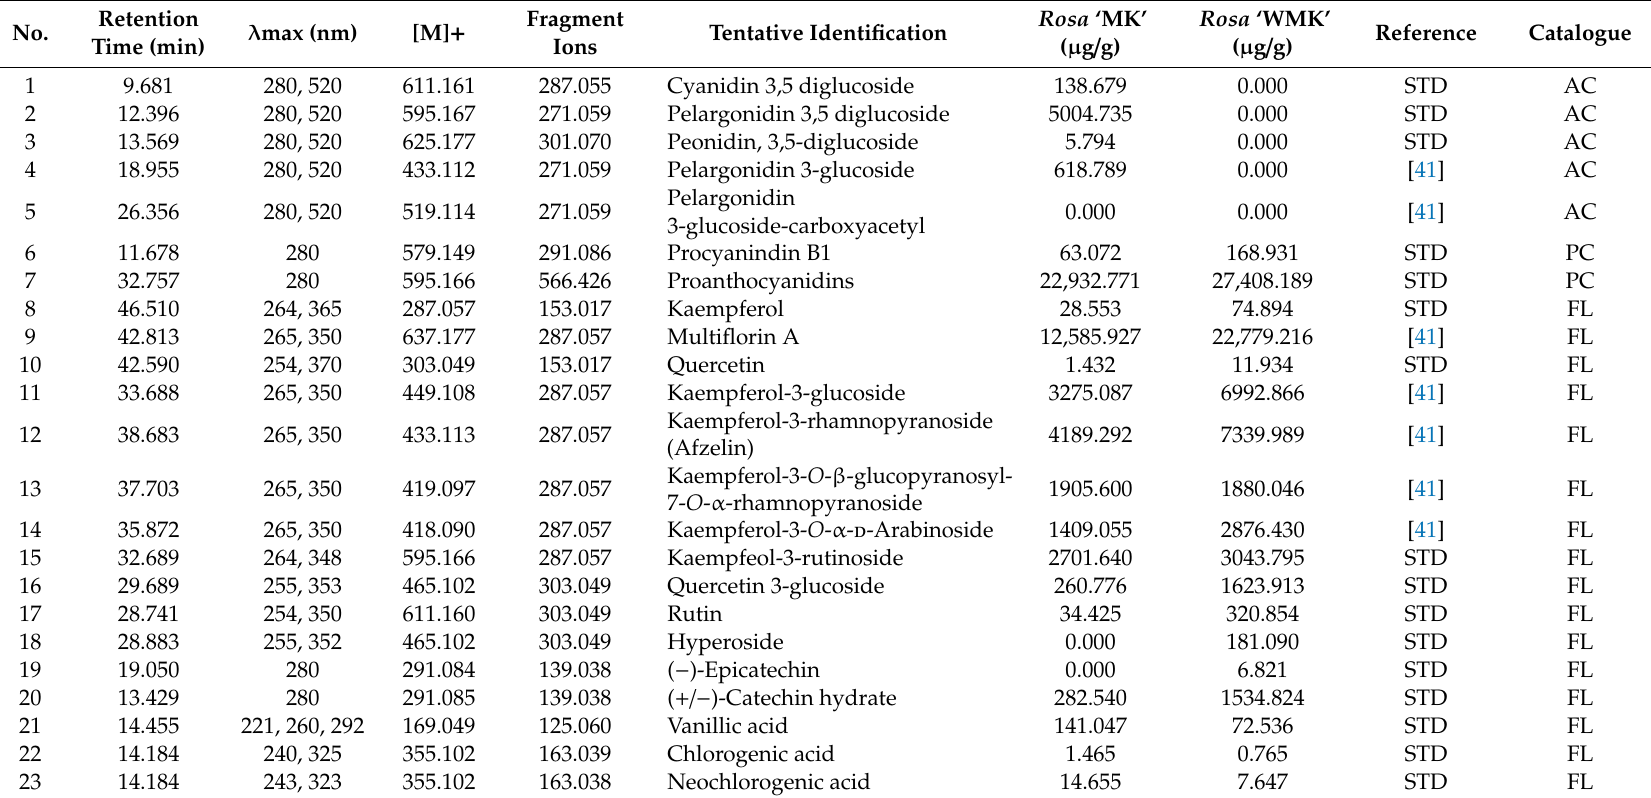
Table 5. Tentative identification and quantification of anthocyanins, procyanidins, and flavonoids in rose